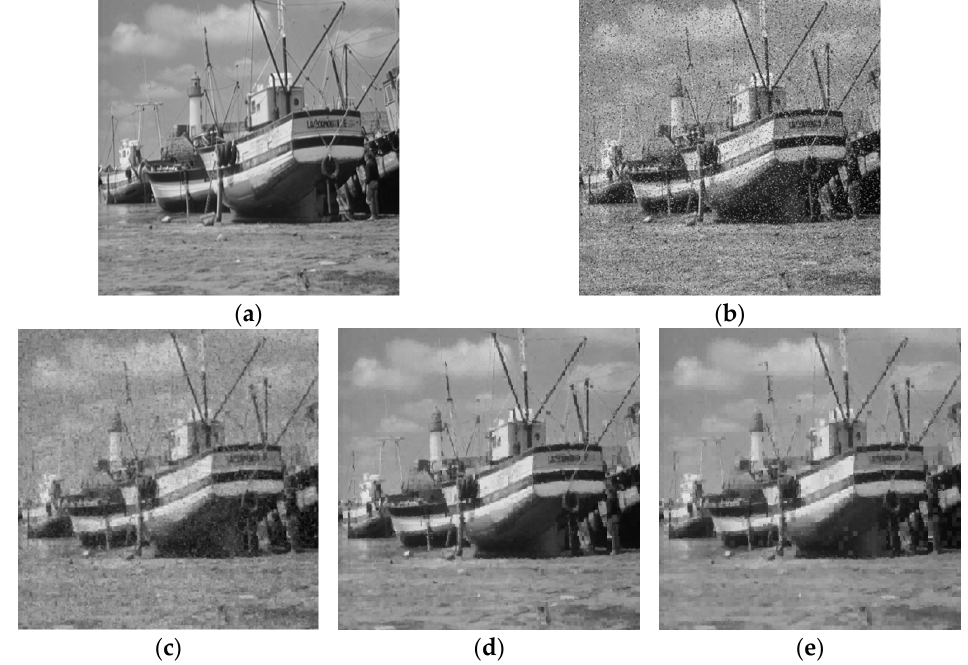
Figure 2. Retrieved images by Full search FIC-LS, RMFIC-H, and RMFIC-TB for Boats image corrupted by 10% salt and pepper noise. ( a ) Original image, ( b ) Corrupt image, ( c ) FIC-LS 22.68 db/9.156 s, ( d ) RMFIC-H 25.57 db/1100.34 s, ( e ) RMFIC-TB 24.56 db/5832.00